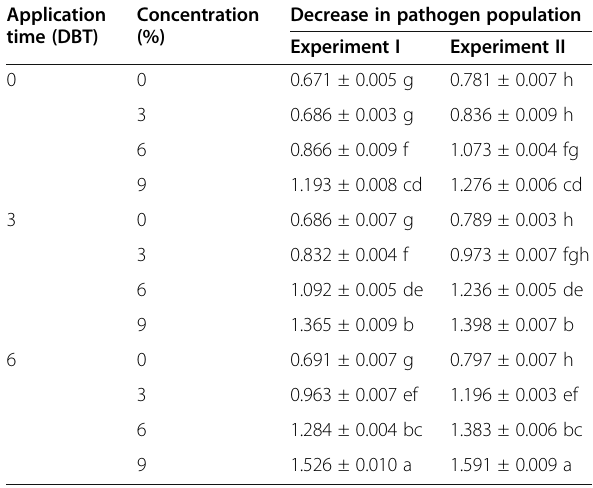
Table 1 Effect of fungal metabolites on decrease in soil bacterial population of R. solanacearum